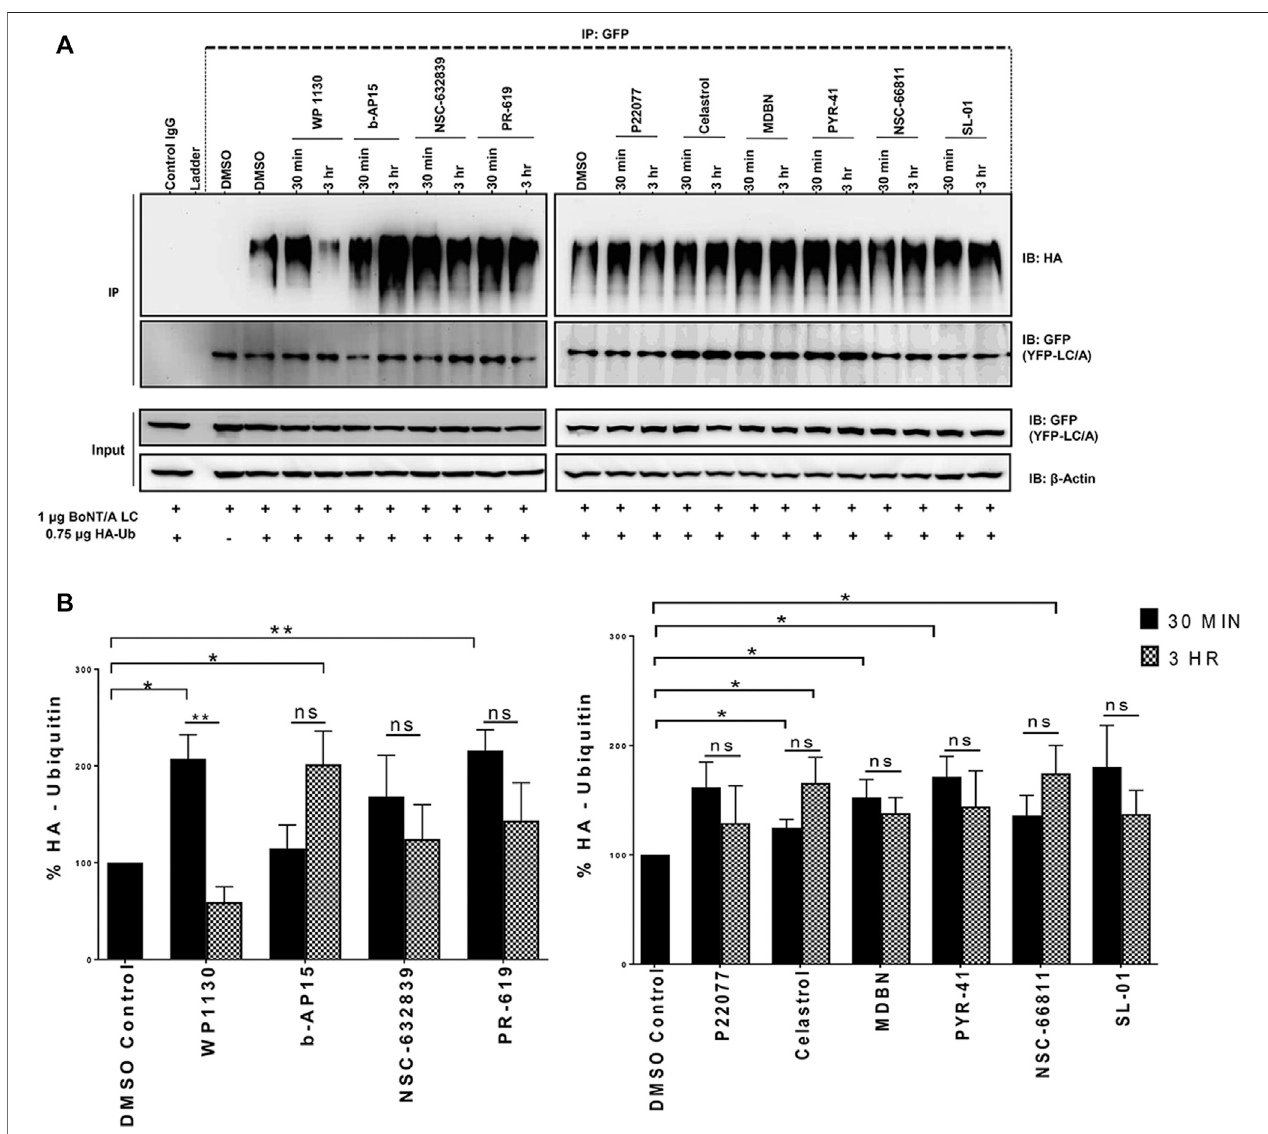
FIGURE 6 | Selected Compounds Promote the Ubiquitination of BoNT/A LC in Cells. (A) HEK293 cells were co-transfected with HA-Ubiquitin and YFP-tagged BoNT/A LC plasmids for 24 h, then treated with the compounds (20 µM), and samples were collected at the indicated time points. YFP-tagged BoNT/A LC was immunoprecipitatedwithGFPantibodiesoranormalmousecontrolIgG,andanHAantibodywasutilizedtodetectubiquitination.Eachblotwasstrippedandre-probed with GFP antibodies. (B) Quantitative analysis of YFP-LCA ubiquitination levels in each compound treated conditions as compared DMSO control condition at the indicated time points. Data in each blot was normalized to corresponding GFP (YFP-A/LC) levels. Data are presented as means ± SEM calculated from three independent experiments and compared by Student ’ s t -test, using GraphPad Prism. “ ns ” stands for not signi fi cant.